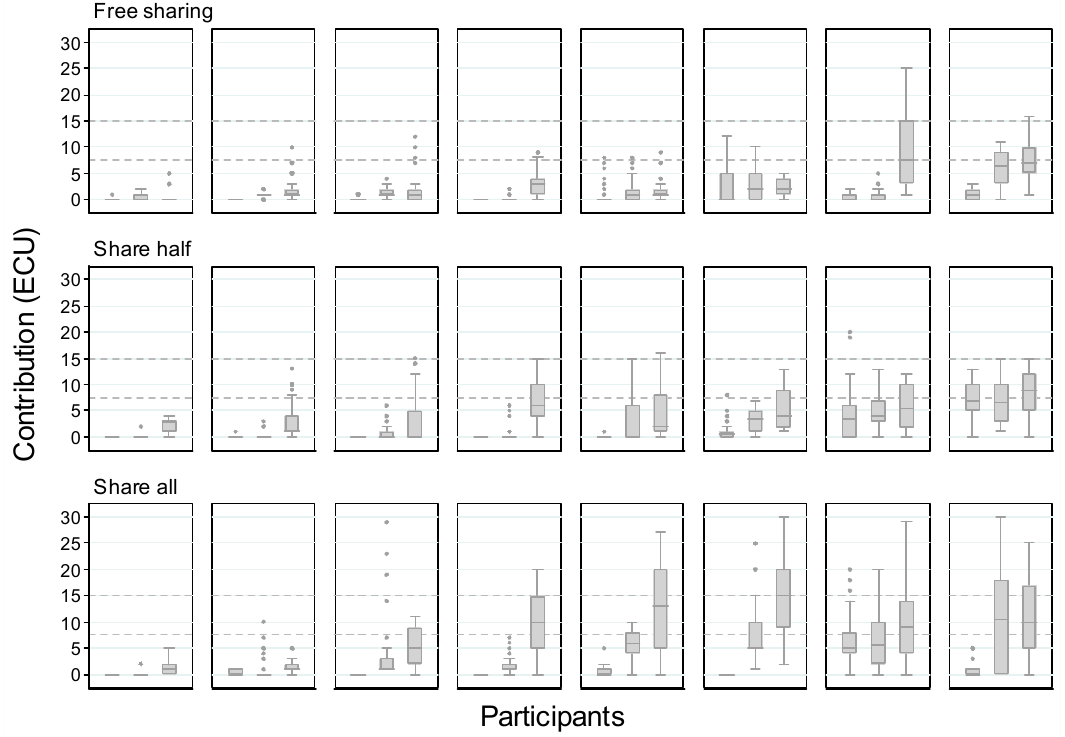
Figure A1. Boxplots for each participant within each group and treatment, with Free Sharing in the first row, Share Half in the second row and Share All in the third. The groups are ordered within a treatment according to the mean contribution per group. Within a group, individual contributions are also ordered by mean contribution.